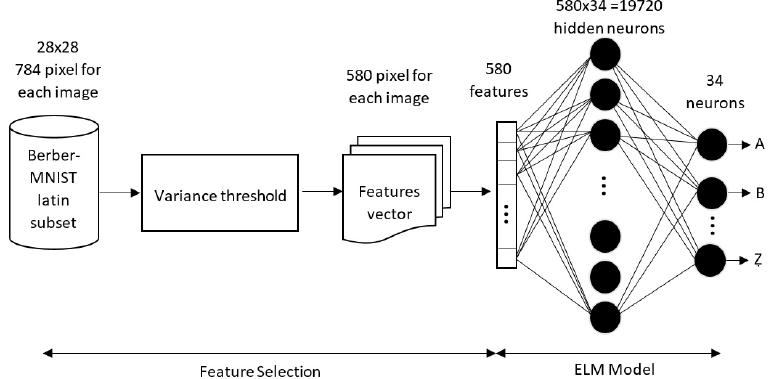
Fig. 1. The proposed system